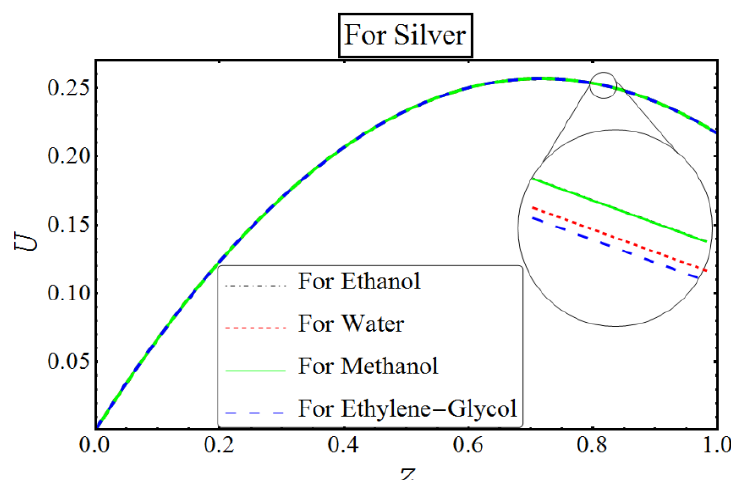
Figure 9. Behavior of radial velocity for each fluid comprising silver particles.